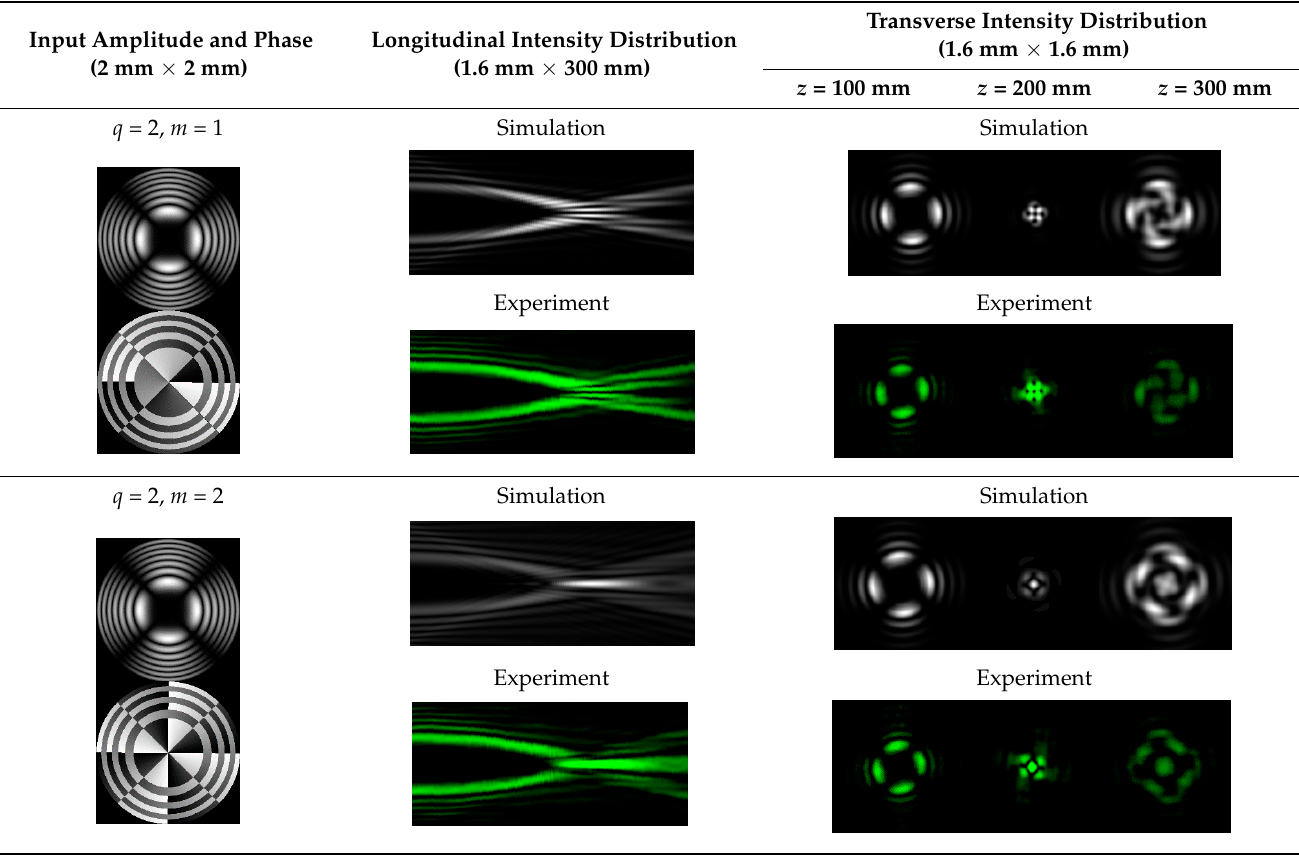
Table 3. Results of TEFD simulation for the field defined by Equation (18) with azimuthal modula- tion of order q = 2 and with different orders of additional vortex phase singularity m .